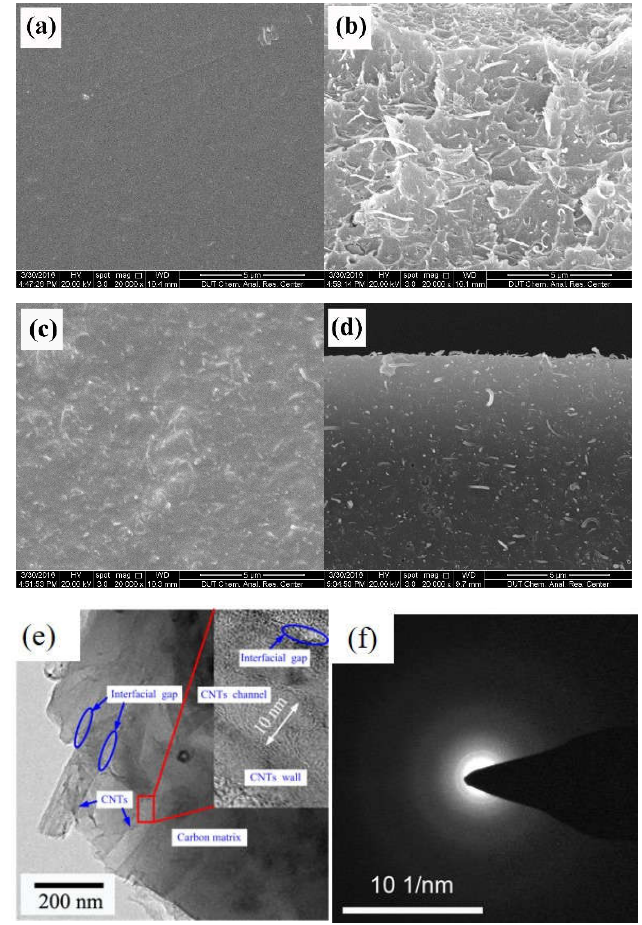
Figure 22. Micromorphology of the obtained CNT-related hybrid membranes. ( a ) Surface and ( b ) cross-section SEM images of CNT/PAA composite membranes; ( c ) surface and ( d ) cross-section SEM images of CNT/C hybrid membranes; ( e ) HRTEM image of CNT/C hybrid membrane; and ( f ) selected area diffraction (SAED) pattern of MWCNTs [89].